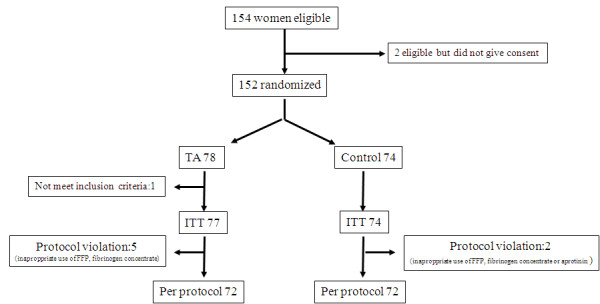
Diagram showing the study profile. ITT, intention to treat; FFP, fresh frozen plasma.